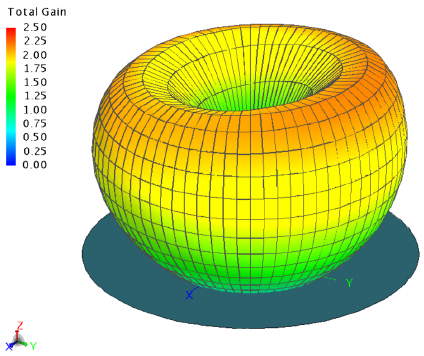
Figure 3. Far-field radiation pattern of SF model 1.